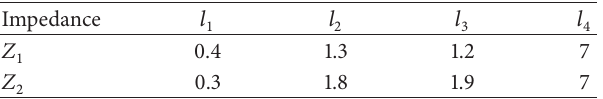
Table 3: Dimensions of ameliorated artificial transmission lines of 𝑍 𝑍 1 , 2 (unit: